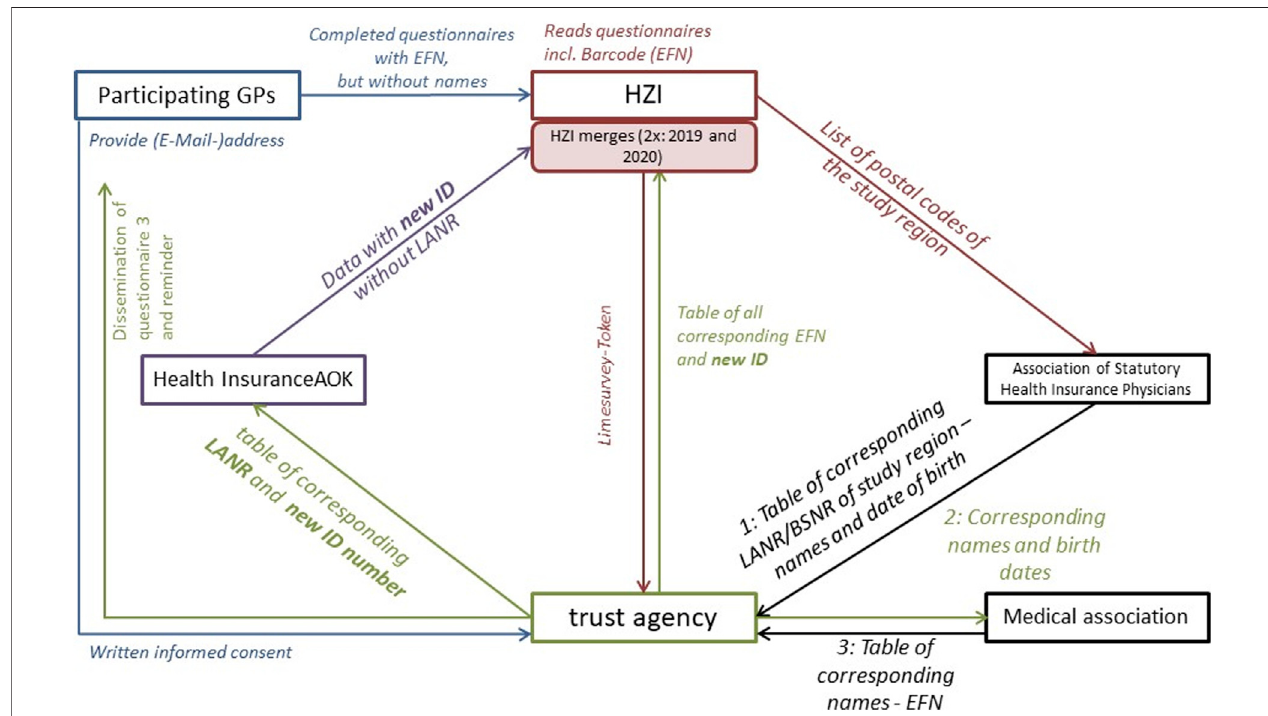
FIGURE1| DataFlow-matchingofprimaryandsecondarydatawithrespecttodataprotectionrequirements.HZI:Helmholtz-ZentrumfürInfektionsforschung,GP: general practitioners, EFN: number used to collect CME points, LANR: personal physician number, BSNR: practice number.